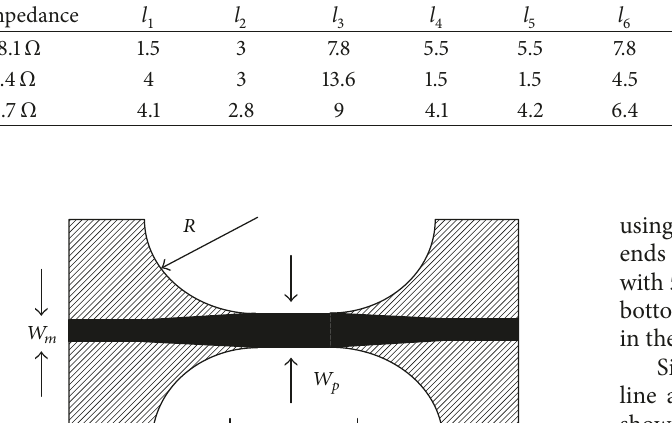
loss is more than 19